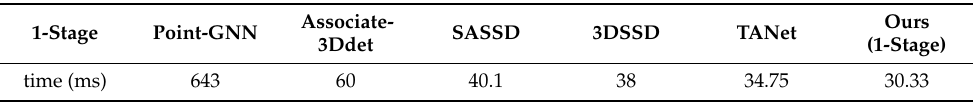
Table 11. Comparison of our model with other single-stage detectors on run time performance. Results are in milliseconds.